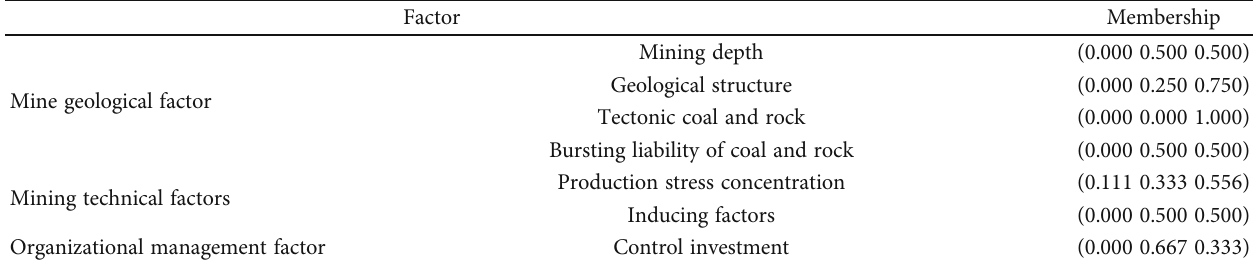
Table 16: Membership degree of each